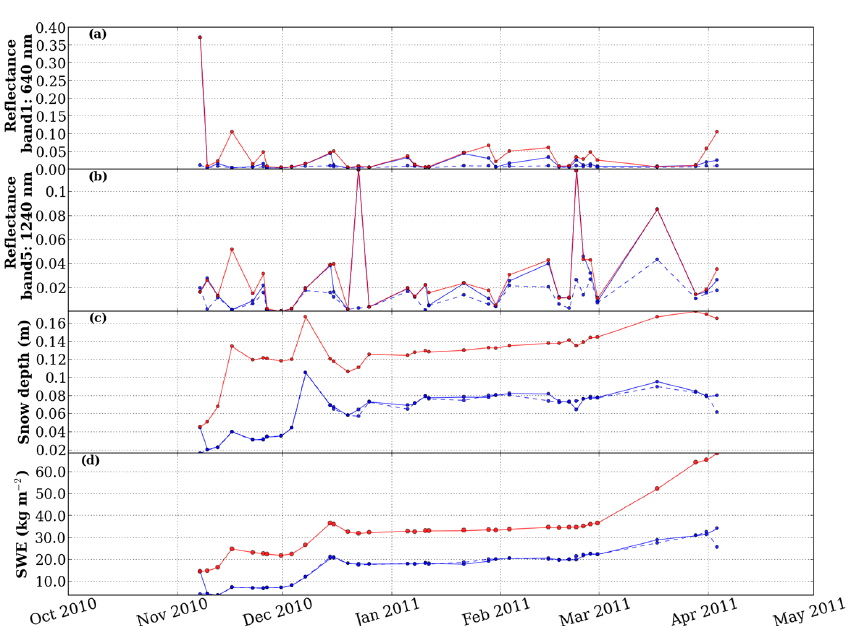
Figure 4. Time evolution of the ensemble RMSEs on (a) reflectance at 640nm, (b) reflectance at 1240nm, (c) SD and (d) SWE, over the 2010/2011 season, for the run without assimilation (red lines), and the baseline assimilation experiment (blue solid line: forecast; blue dotted line: analysis). Dots indicate analysis